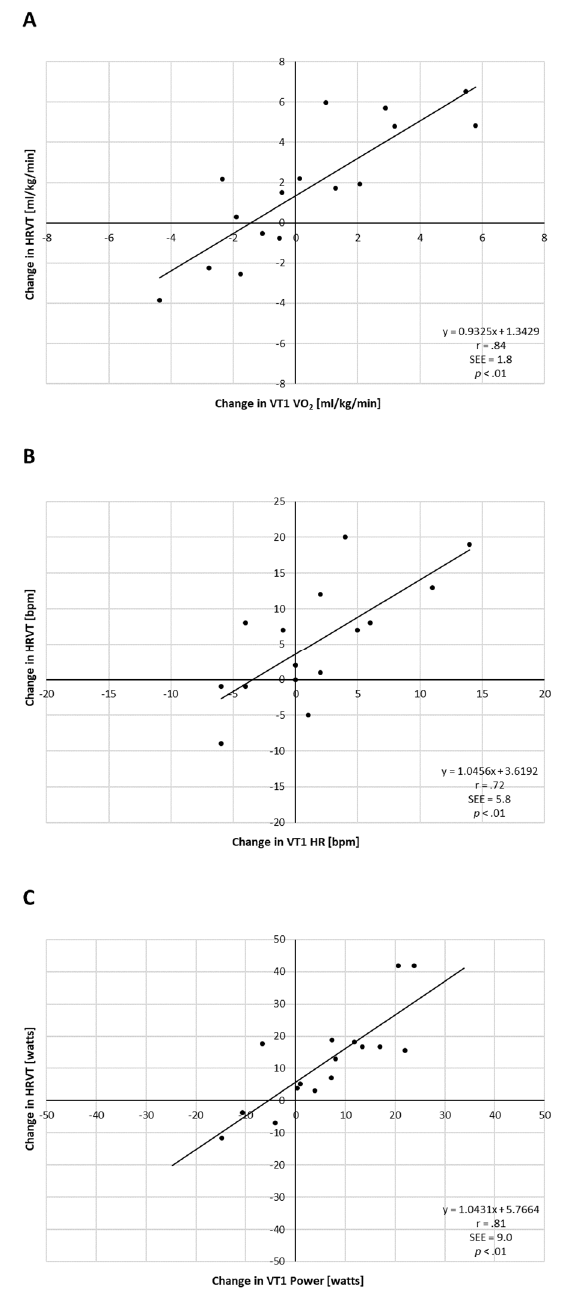
Figure 3. Analysis of individual improvement PRE vs. POST exercise intervention for all participants. ( A ) Change in measured VT1 vs. HRVT for VO 2 ; ( B ) change in measured VT1 vs. HRVT for HR; ( C ) change in measured VT1 vs. HRVT for Power. Pearson’s r, SEE (standard error of estimate) and p value of regression line listed.